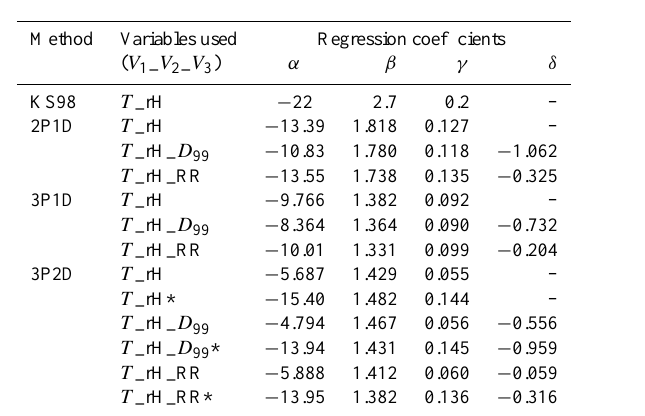
Table 4. List of regression coefficients calculated with Eq. (7) by minimizing the sum of squared errors with respect to the manual PP reference data for two PPs using one PP distribution (2P1D; Sect. 3.1), three PPs using one PP distribution (3P1D; Sect. 3.2), and three PPs using two PP distributions (3P2D; Sect. 3.3). For 3P2D, the asterisk denotes the rain distribution that was derived setting the mixed phase to snow. KS98 denotes the coefficients recommended by Koistinen and Saltikoff (1998) derived over Finland.